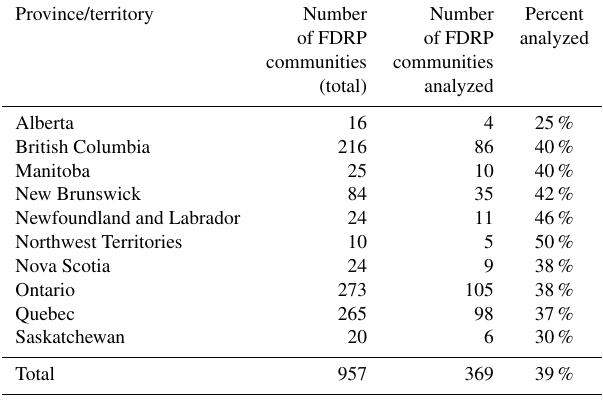
Table 1. Number and percentage of FDRP communities analyzed by province or